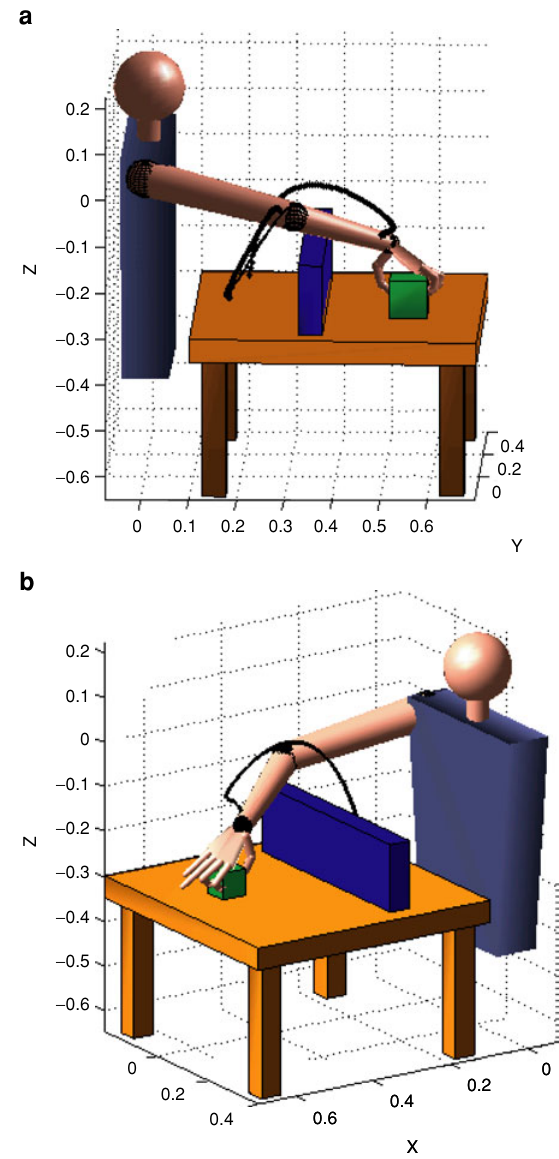
Figure 12 Modelisation illustration. (a) Wrist and Elbow trajectory. (b) Wrist trajectory.